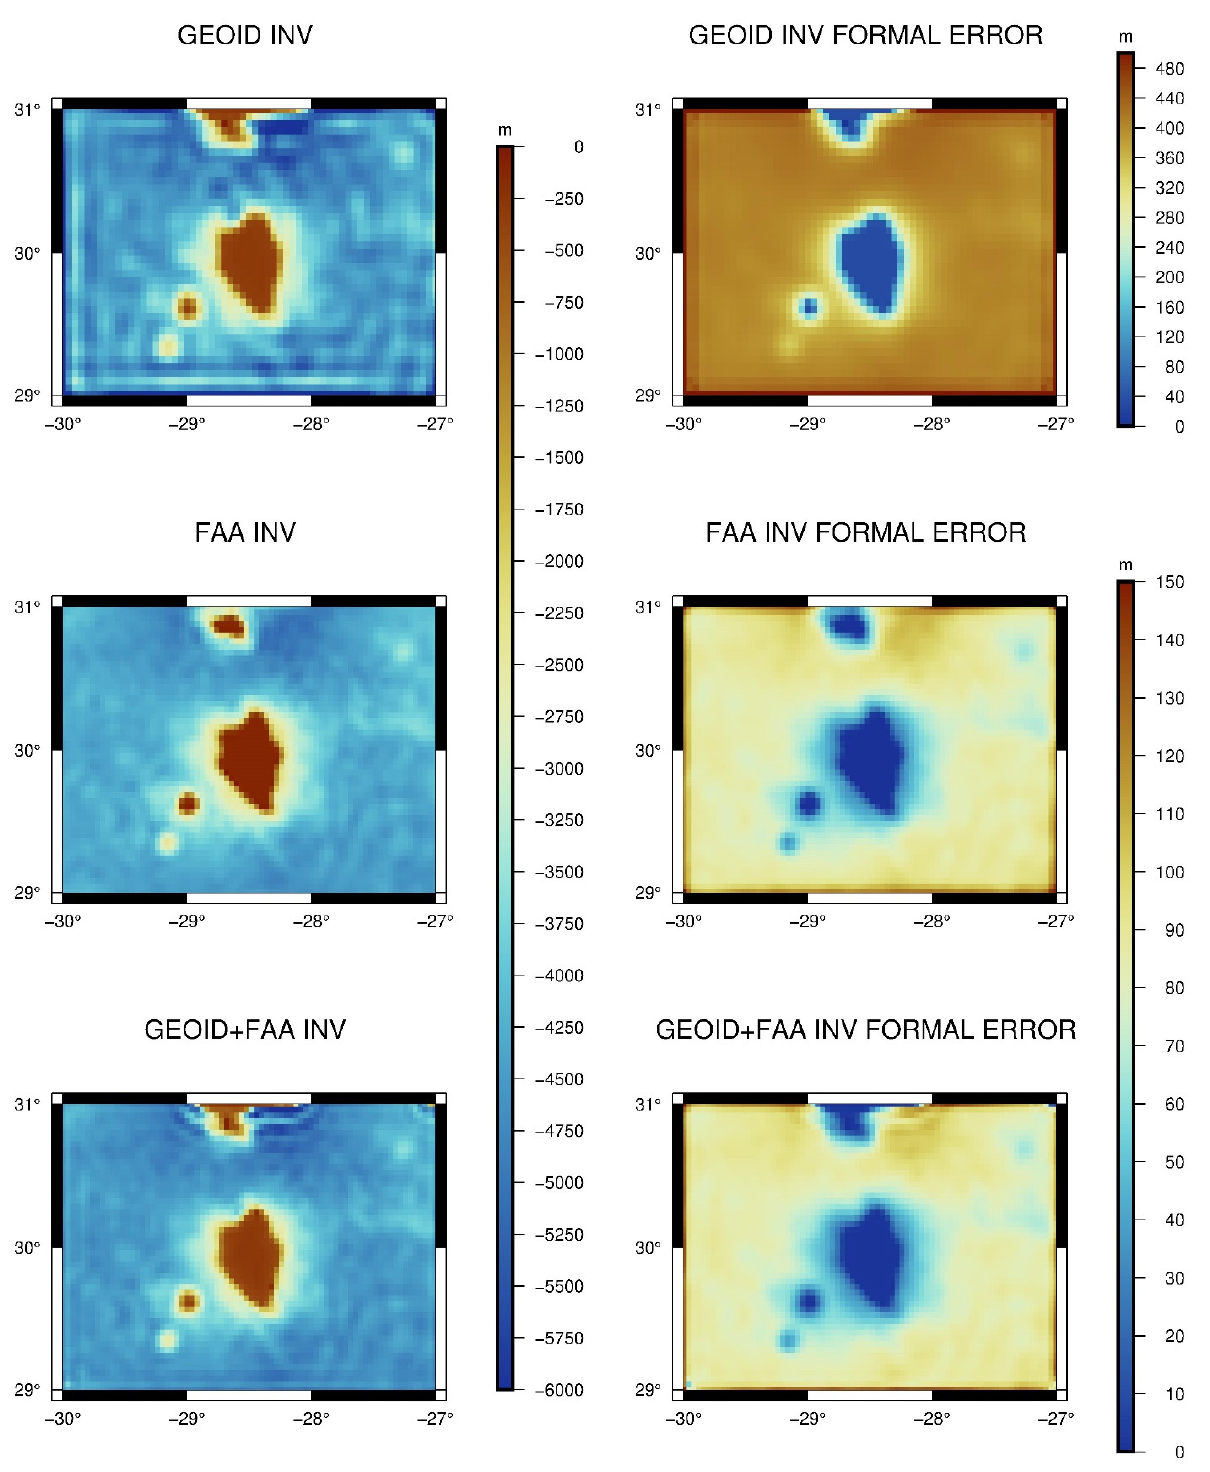
Figure 9. Bathymetry solutions ( left ) for inversion of geoid heights, free-air anomalies, their combi- nation and their associated formal errors ( right ). Units are meters.